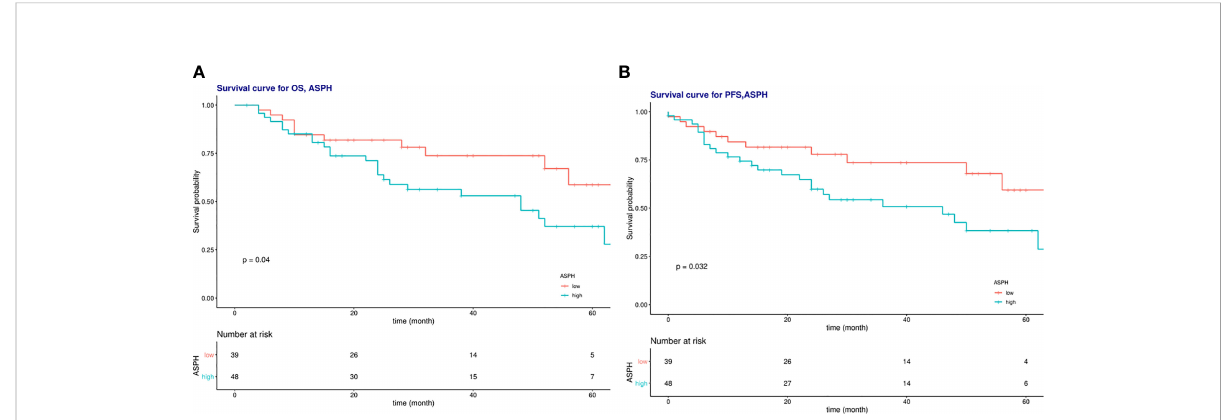
FIGURE 9 (A) Survival curves of overall survival in low ASPH expression and high ASPH expression; (B) Survival c\llVes of progression-free survival in low ASPH expression and high ASPH expression.